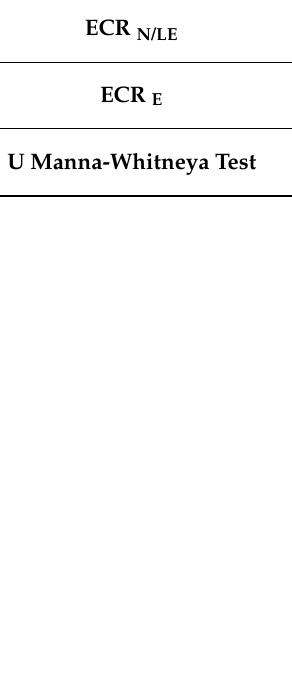
Table 2. Analysis of the effect of local cryotherapy on the MNF value recording during a 60 s